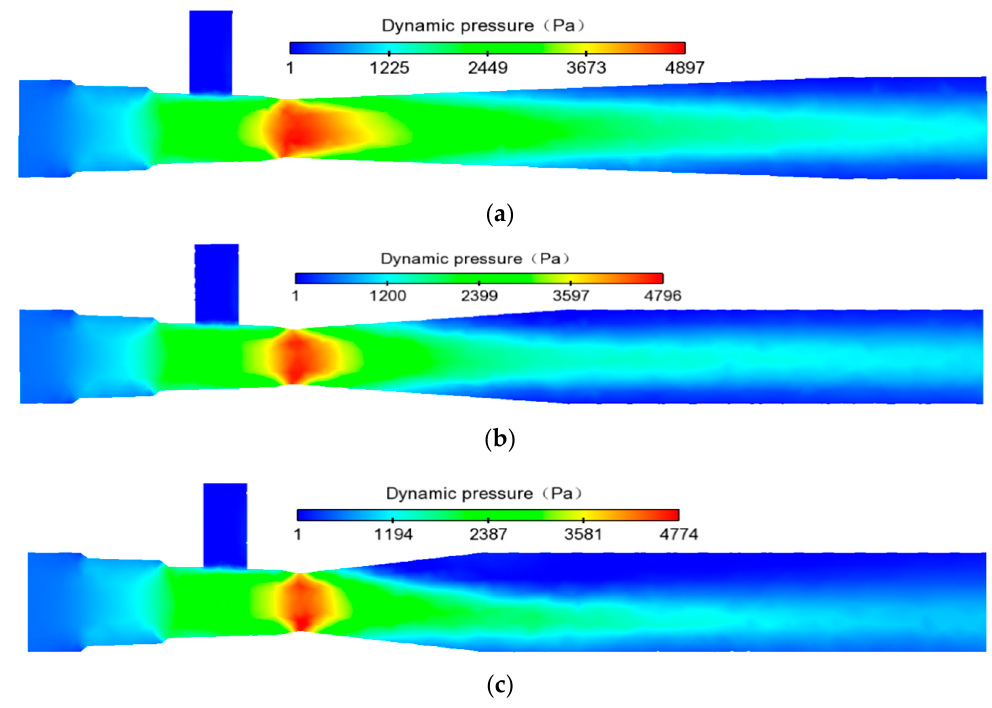
Figure 14. Dynamic pressure field nephogram: ( a ) type A, ( b ) type B, and ( c ) type C.